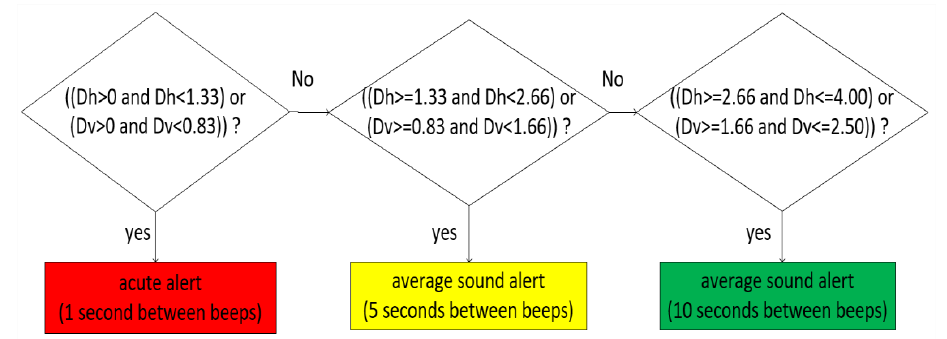
Figure 8. Sound alert scheme based on obstacle distance.